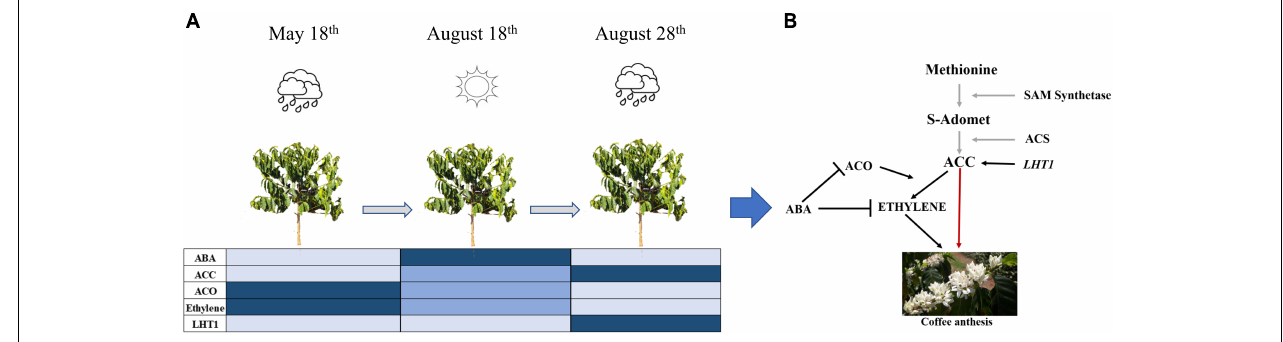
FIGURE 7 | Proposed model of ABA-ACO-Ethylene regulation favoring ACC increased level influencing coffee anthesis in the ethylene biosynthesis pathway. (A) Evolution of phytohormones (ABA, ACC, ACO, Ethylene) and LHT1 transporter measured in this study by the sampling times (May 18th, August 18th, and August 28th). The color intensity in the chart means the level of plant hormone in the coffee plant as a whole (Light blue = low, blue = medium, dark blue = high). (B) Relationship among phytohormones according to our proposal, the black arrow means established plant hormones relation in this study, gray ones mean part of ethylene biosynthesis process described in the literature, the red arrow means a proposal of this study of ACC acting in coffee